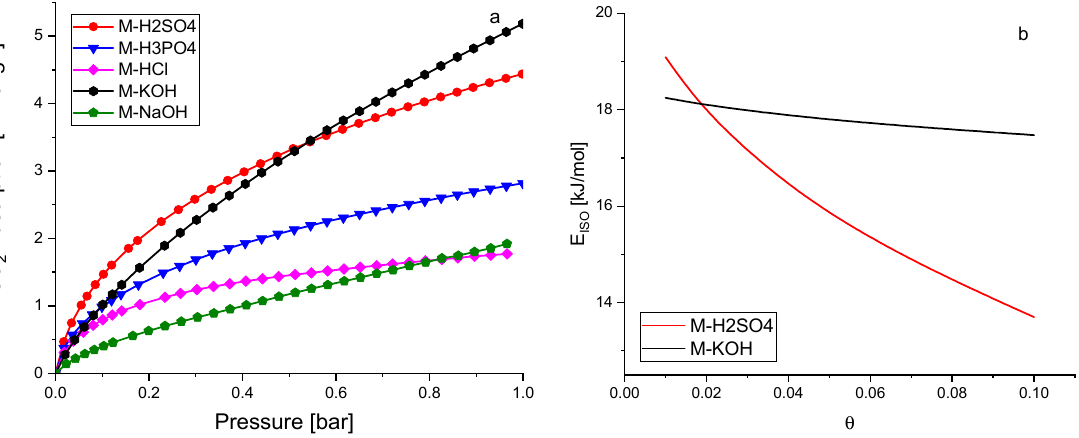
Figure 5. CO 2 adsorption at a temperature of 0 °C over activated carbons from molasses ( a ), the isosteric heat of adsorption for M-KOH and M-H 2 SO 4 ( b ). Table 3. The pore size (diameter) important for CO 2 adsorption at different temperatures. Temperature